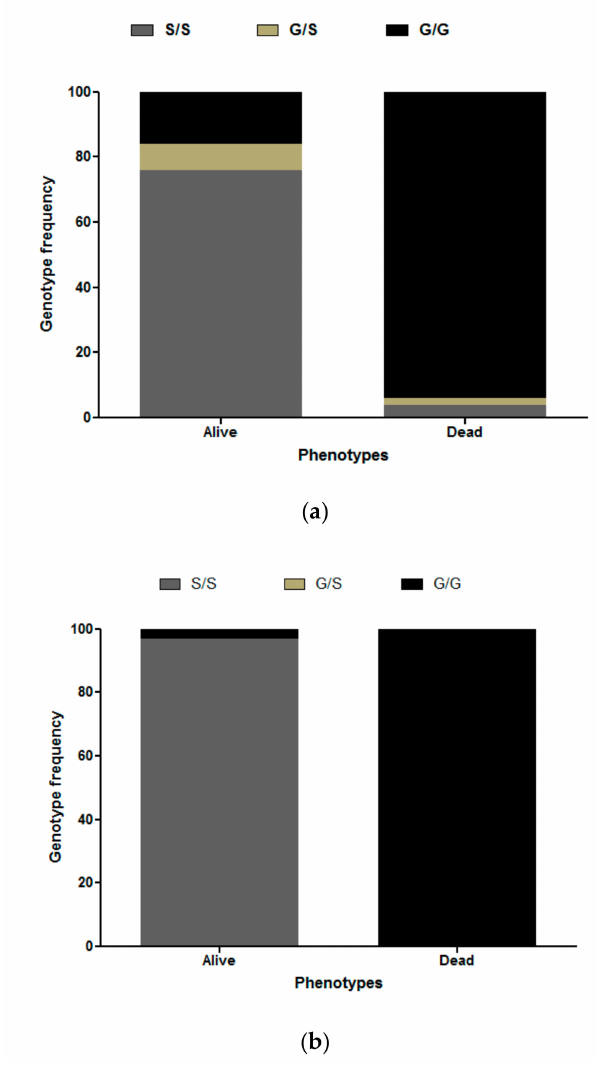
Figure 2. Distribution of Ace-1 G119S genotypes and association with bendiocarb ( a ) and propoxur ( b ) resistant phenotype. Homozygote resistant (S / S), heterozygote (G / S), and homozygote susceptible (G / G